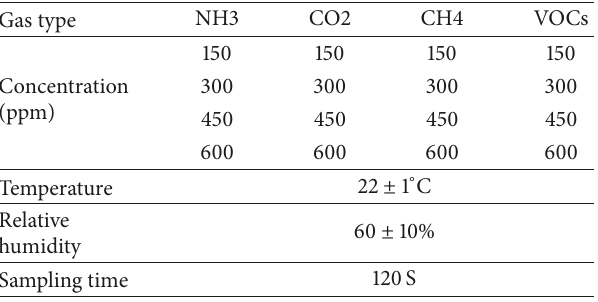
Table 1: Samples and experimental